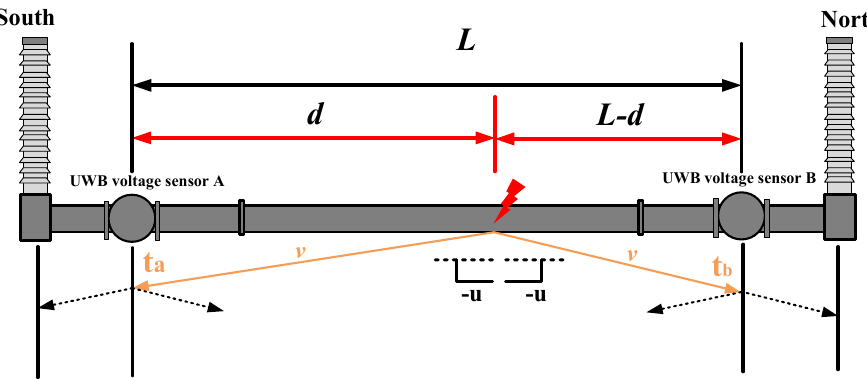
Figure 5. Schematic diagram of two-terminal traveling wave location principle of GIL.